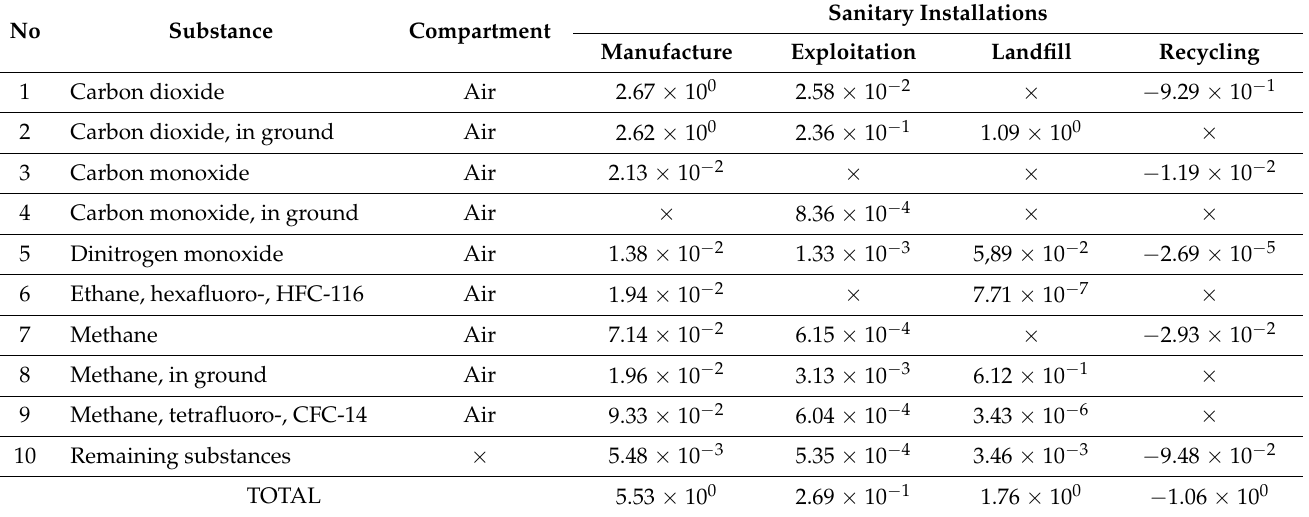
Table 13. The results of grouping and weighing the environmental consequences of emissions of compounds causing climate change due to sanitary installations occurring at individual stages of the life cycle of the research